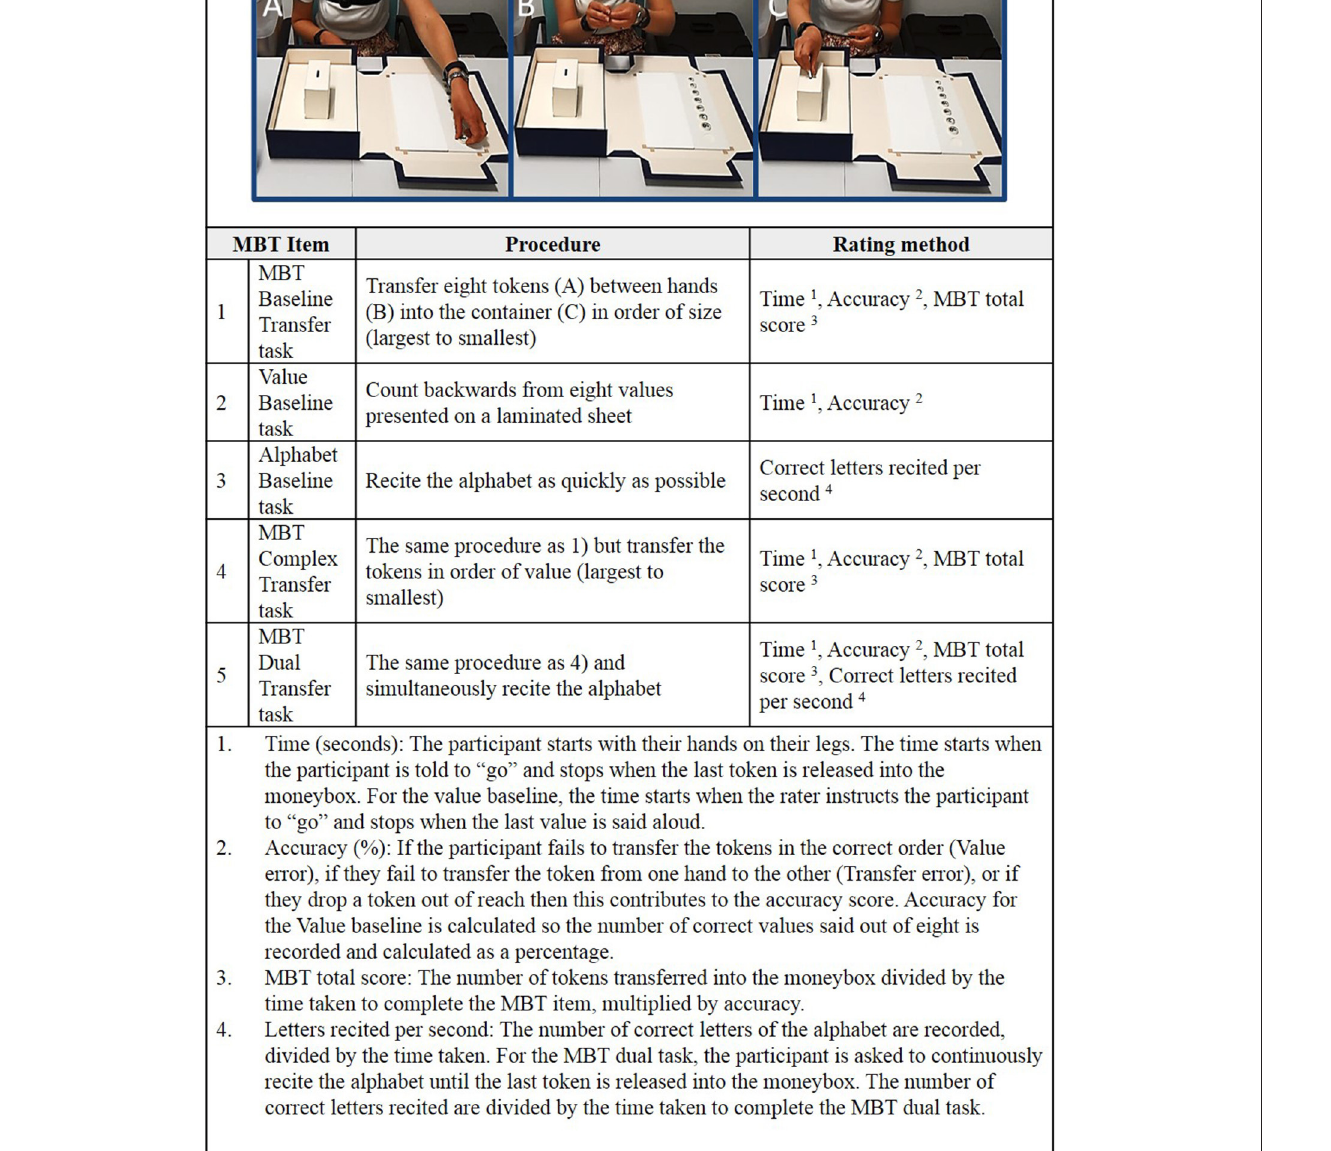
recited in the MBT Dual Transfer task vs. the verbal fluency and the Stroop color naming (see Table 4 ).